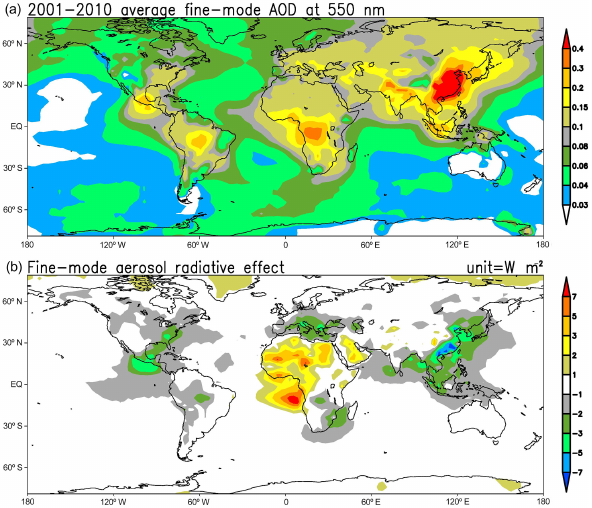
Figure 3. (a) The 2001–2010 mean 550nm fine-mode AOD (fAOD) obtained by integrating MODIS, MISR and AERONET data. (b) The 2001–2010 mean direct fine-mode aerosol radiative effect at TOA in units of Watts per square meter; this estimate in- cludes natural fine-mode